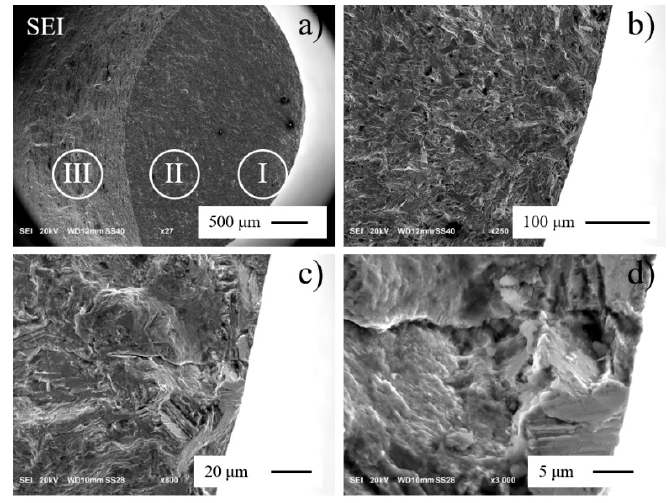
Figure 13. SEM fracture images of aged Inconel 718 ( R = − 1, f = 20 kHz, σ a = 540 MPa, Nf = 1.57 × 10 9 cycles): ( a ) fatigue fracture, ( b ) initiation-low zoom; ( c ) secondary crack, ( d ) initiation-high